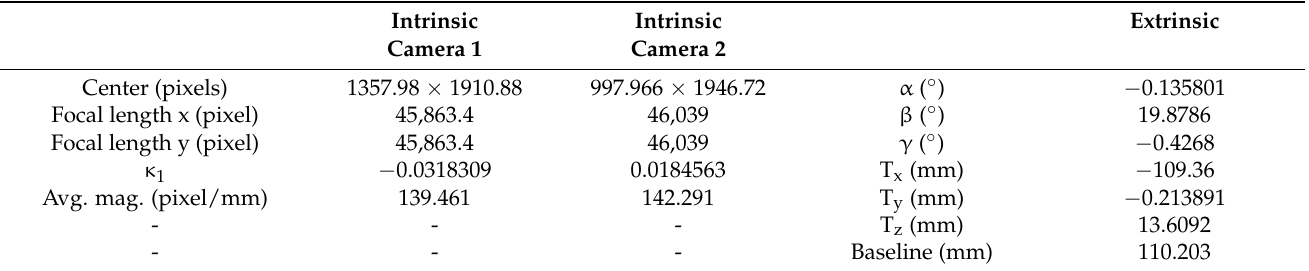
Figure 2. ( a ) Example of speckle pattern. ( b ) Pictures of INSTRON machine used in this work with the customized forced convection oven and the 3D-DIC camera setup. The stereo-angle β is indicated. Table 3. Values of intrinsic and extrinsic calibration parameters obtained for Test E.